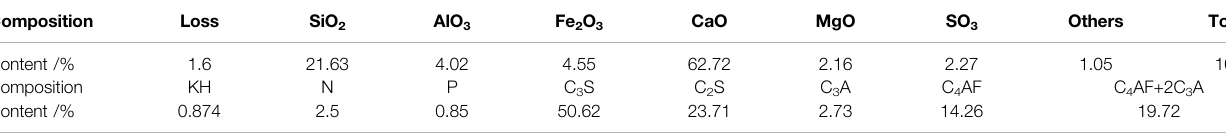
TABLE 1 | Chemical composition and mineral composition of the Glass G oil well cement. Composition